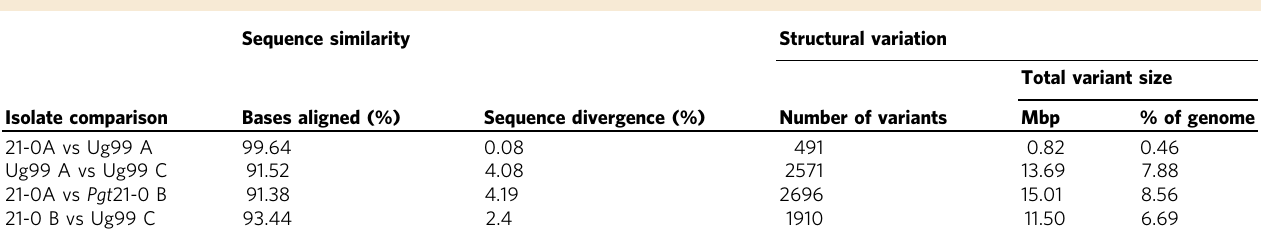
Total variant size